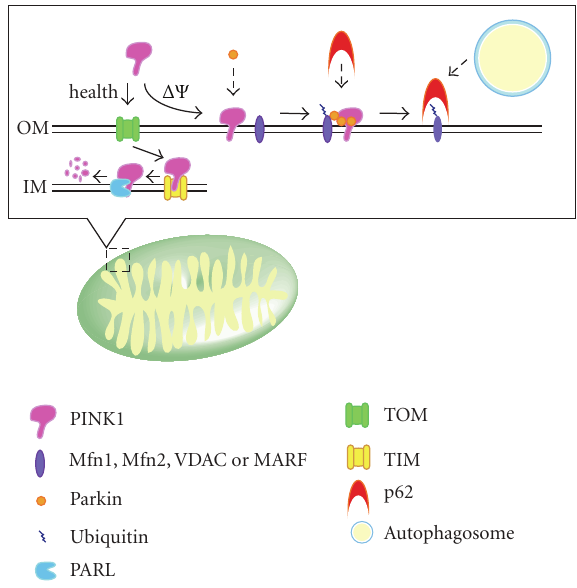
Figure 2: Parkin/PINK1 and mitophagy in higher eukaryotes. PINK1 is constitutively targeted and imported into the inner mem- brane via the mitochondrial import machinery, the TOM and TIM complexes, and degraded by presenilin-associated rhomboid-like protein (PARL). When the mitochondrial membrane potential is depolarized, PINK1 cannot translocate across the mitochondrial outer membrane and instead accumulates on it. PINK1 on the outer membrane causes the translocation of Parkin to mitochondria which triggers the ubiquitination of mitofusin 1 (Mfn1), mitofusin 2 (Mfn2), and voltage-dependent anion channel 1 (VDAC) in mam- mals, and mitochondrial assembly regulatory factor (MARF) in flies. The ubiquitinated proteins on mitochondria are captured by p62, a substrate of autophagy that can bind ubiquitinated proteins, resulting in the sequestration of mitochondria into autophago- somes. OM: outer membrane; IM: inner